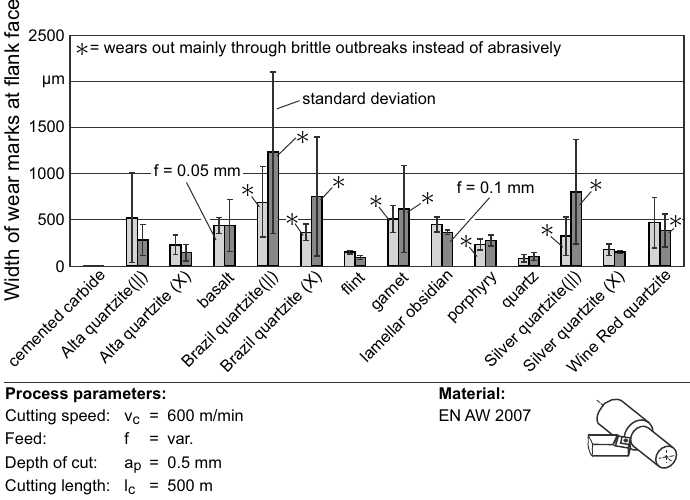
Fig. 17 Width of wear marks at the flank face of the rock inserts for a depth of cut of 0.5 mm